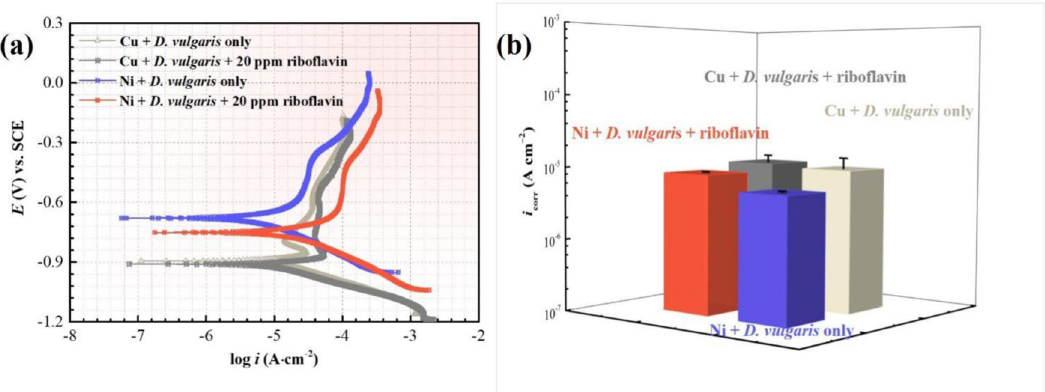
Fig. 14 Potentiodynamic polarization and i corr . a Potentiodynamic polarization curves, b i corr analysis of the Cu and Ni coupons after the 7-d incubation in the D. vulgaris media without and with ribo fl avin. (Error bars stand for the standard deviations from at least three independent coupons).